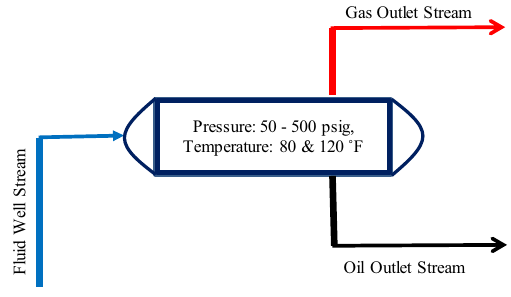
Fig. 10 Schematic separator